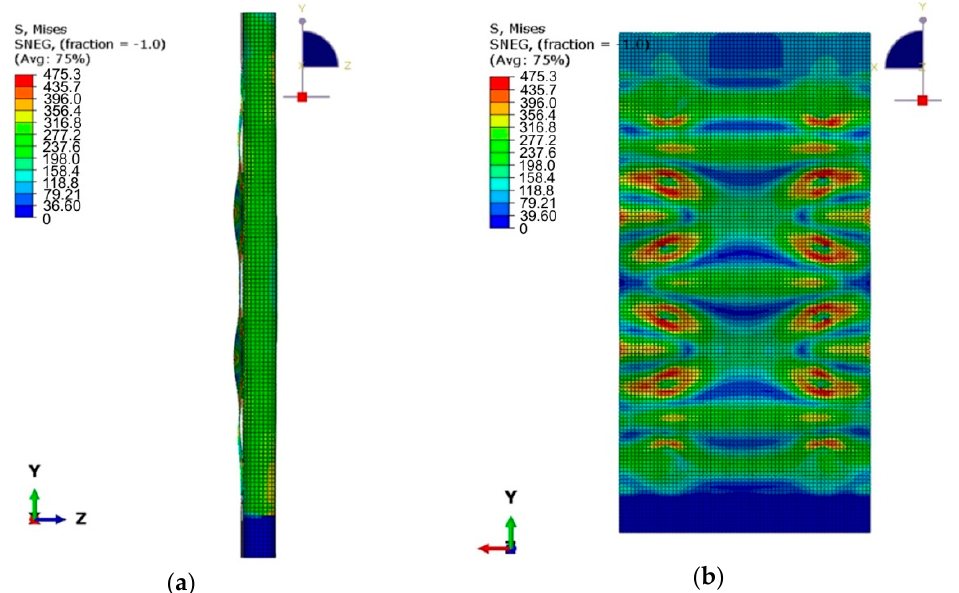
Figure 16. Local buckling of the panel between welds ( a ) and stress accumulation in the vicinity of the welds ( b ) for the welded stiffened panel with a weld spacing of s = 44.25 mm (compressive force of 0.75 F max ).